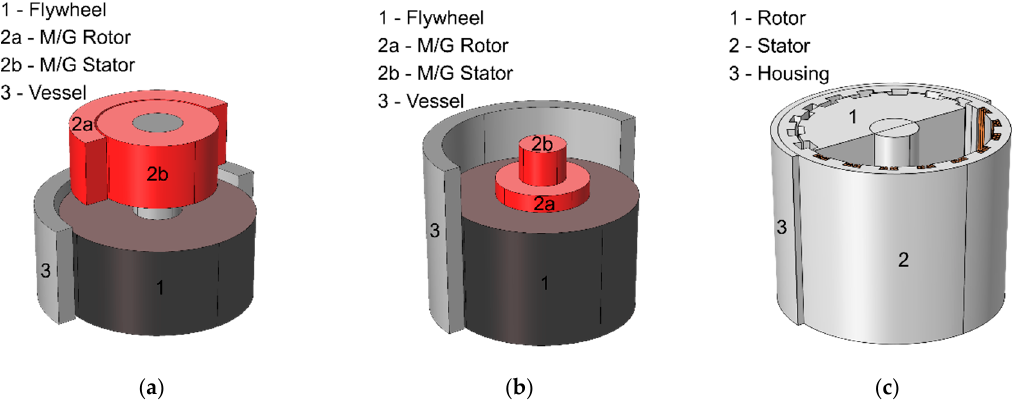
Figure 1. Flywheel unit architecture: ( a ) traditional two-body; ( b ) concentric integrated; ( c ) one-body Figure1. Flywheelunitarchitecture: ( a )traditionaltwo-body;( b )concentricintegrated;( c integrated.